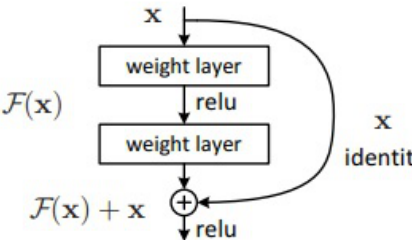
Figure 3. Building block of residual learning